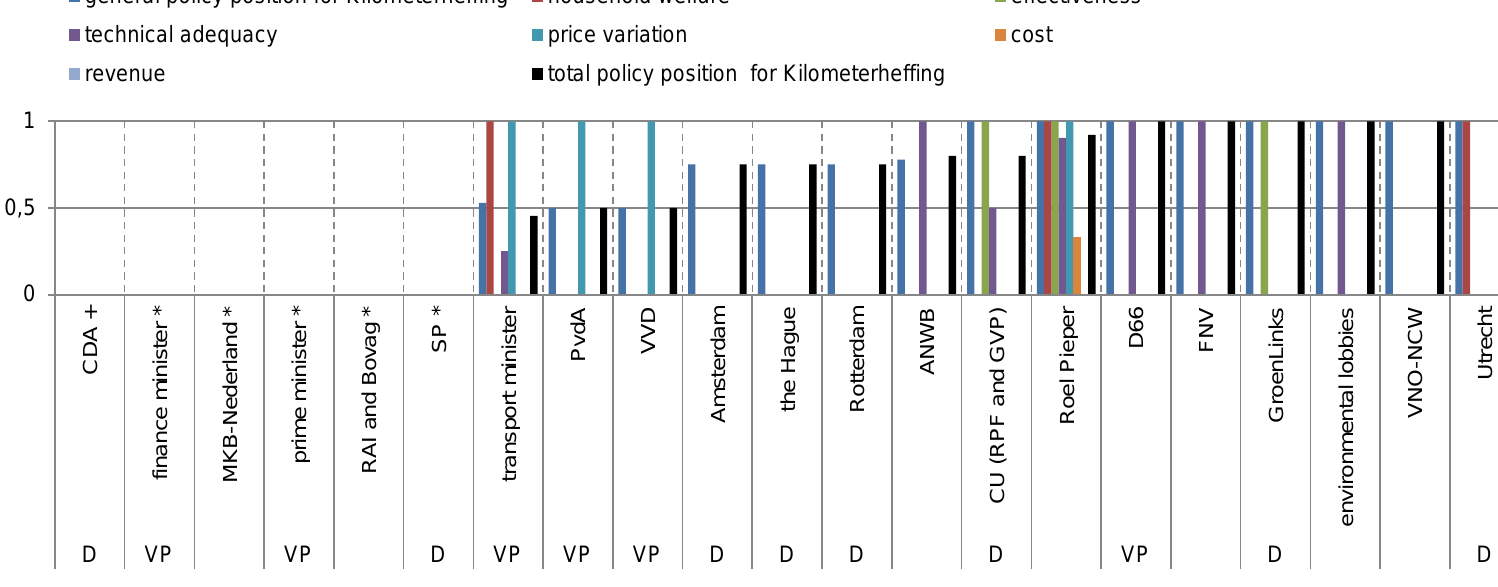
Figure 3. Pro- and anti- Kilometerheffing advocacy coalitions in government period 2 –after the Mobimiles report (1998 –